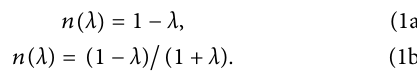
TABLE 1 | In fl uence of two typical breaking functions on the convergence accuracy of Taylor series. η ( λ ) η 9 (0)